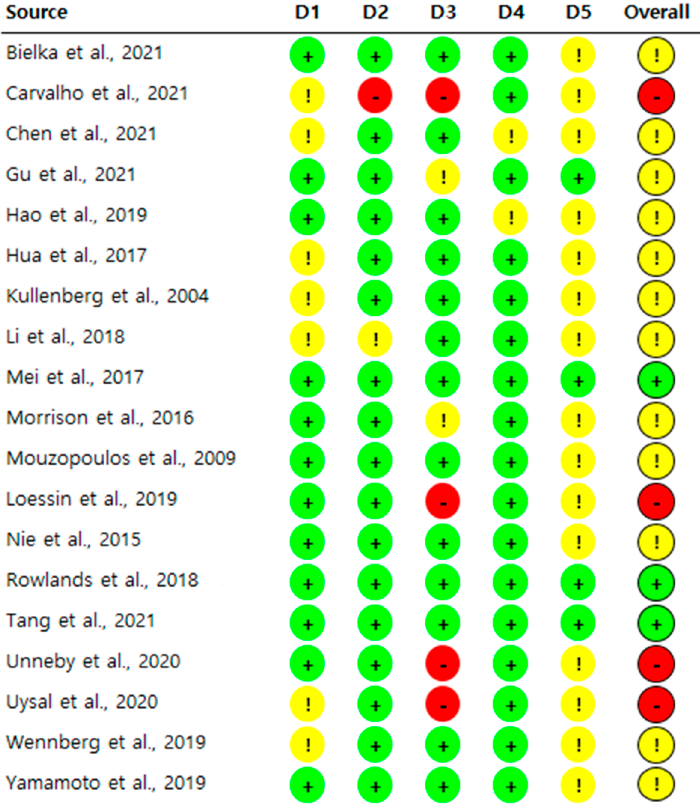
Figure 2. Risk of bias summary [16–19,28–42]. D1, randomization process; D2, deviations from the intended interventions; D3, missing outcome data; D4, measurement of the outcome; D5, selection of the reported result; , low risk; , some concerns; , high risk.